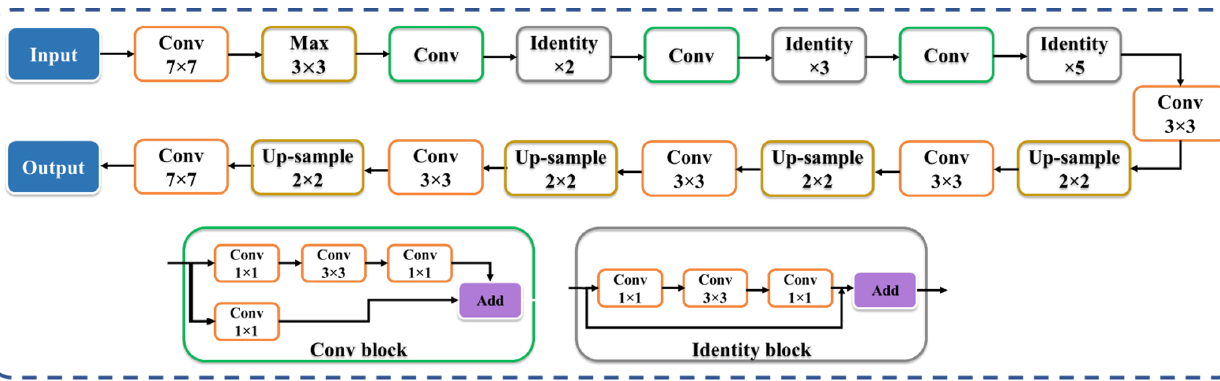
Figure 7. ResNet ‐ SegNet HDL model’s architecture.